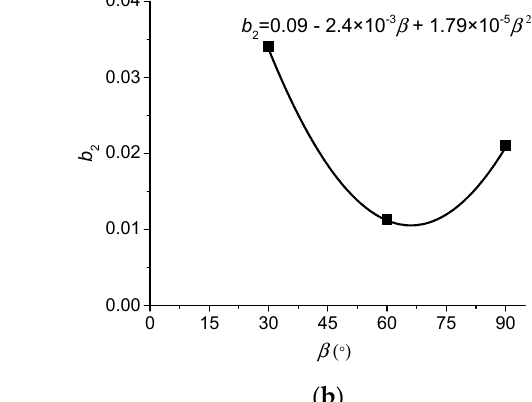
It should be noted that the fitting describes the changing trend of the two parameters for 30 ◦ ≤ β ≤ 90 ◦ ,